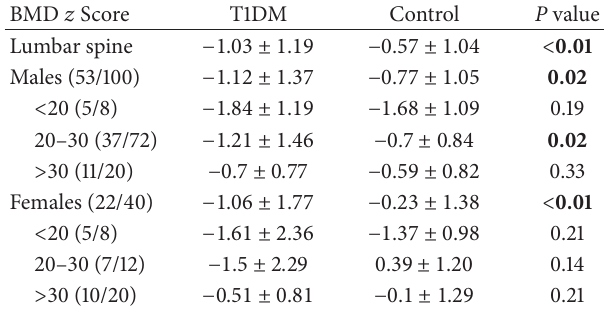
Table 3: Differences in bone mineral density 𝑧 scores in T1DM subjects and age, sex, and body mass index matched controls at total body (expressed as mean ± SD).